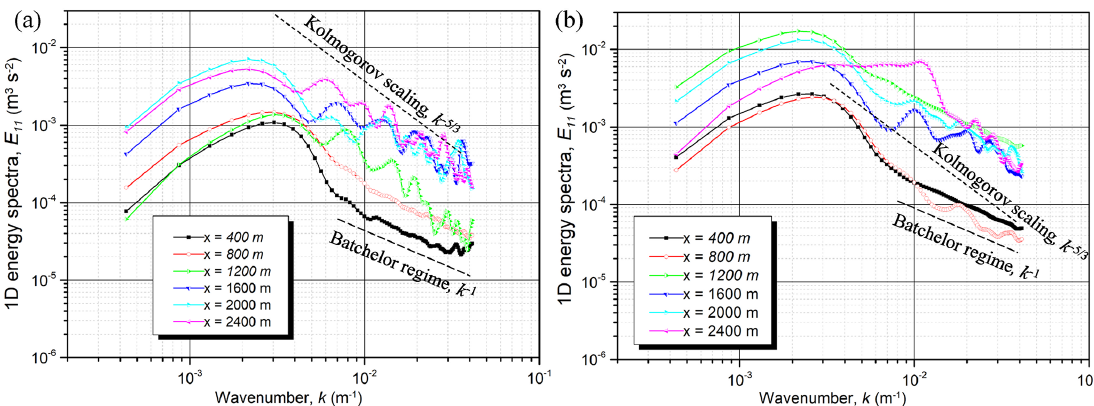
Figure 6. One-dimensional turbulence energy spectra at a depth of 291m at the PISW within the IOBL. (a) n = 3 and (b) n = 7. Different shapes and colors represent the values at different zonal distances: 400, 800, 1200, 1600, 2000, and 2400m. These power spectra are obtained by y -direction (meridional direction) spatial assessment of time-averaged velocity at each x location. The − 5 / 3 slope (Kolmogorov scaling) represents the regime of inertial subrange, whereas the − 1 slope (Batchelor) represents viscous-convective range in the high-Schmidt-number